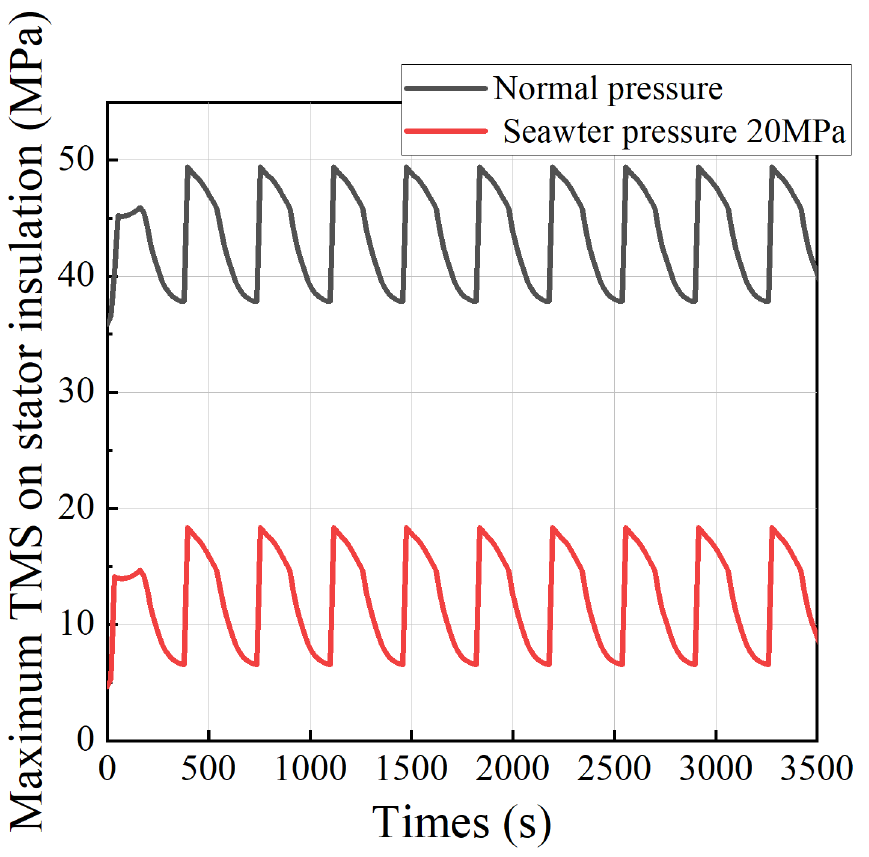
Figure 16. TMS spectra of stator insulation under normal pressure and 20 MPa.